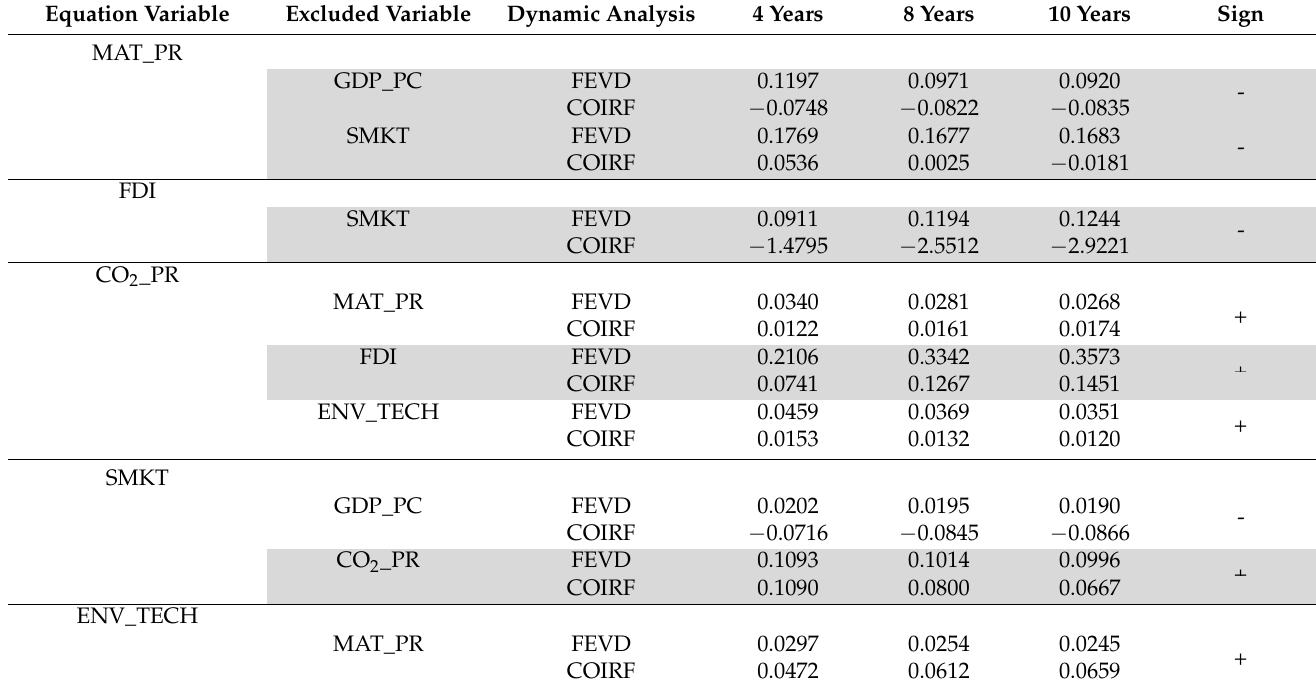
Table 7. Robustness test for the EU-15